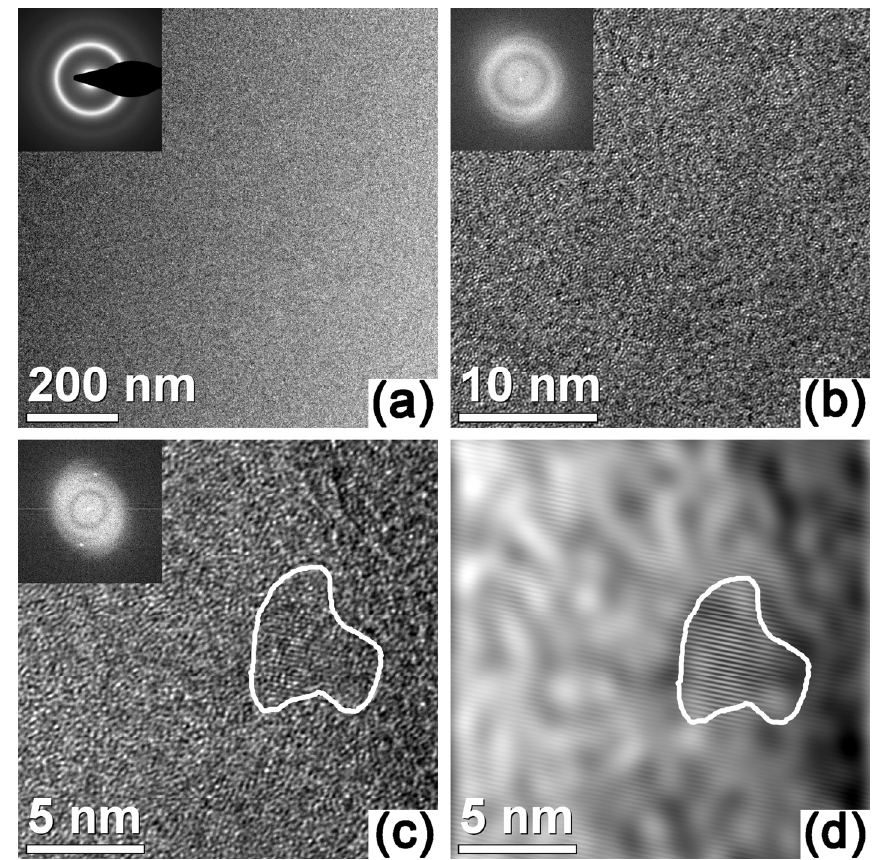
Figure 3. TEM data for the as-cast Zr image of the as-cast material and ( inset ) corresponding selected area electron diffraction pattern; ( b , c ) high-resolution TEM micrographs and ( insets ) corresponding fast Fourier transforms (FFT); ( d ) inverse FFT of Figure 3(c) after the Fourier mask